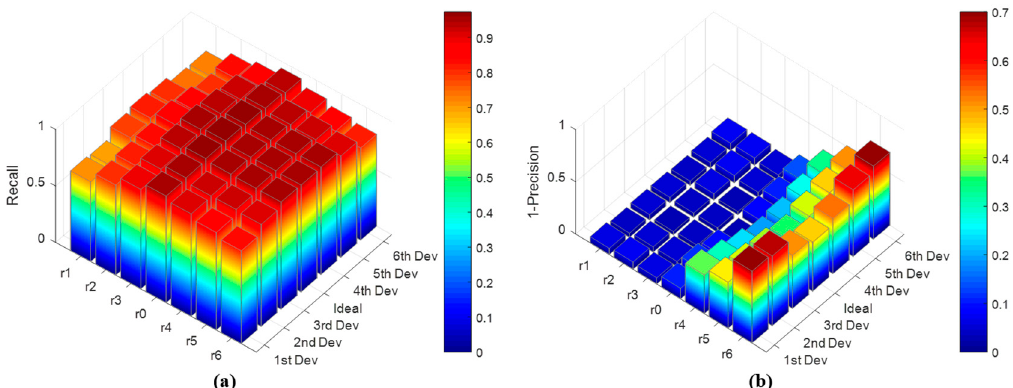
Figure 11. Clustering center coordinate and controlling distance of the ship feature clustering model (SFCM). ( a ) is the Recall rates of the SFCM detection performance with different clustering centers and controlling distances and ( b ) is the 1-Precision rates of the SFCM detection performance with different clustering centers and controlling distances.